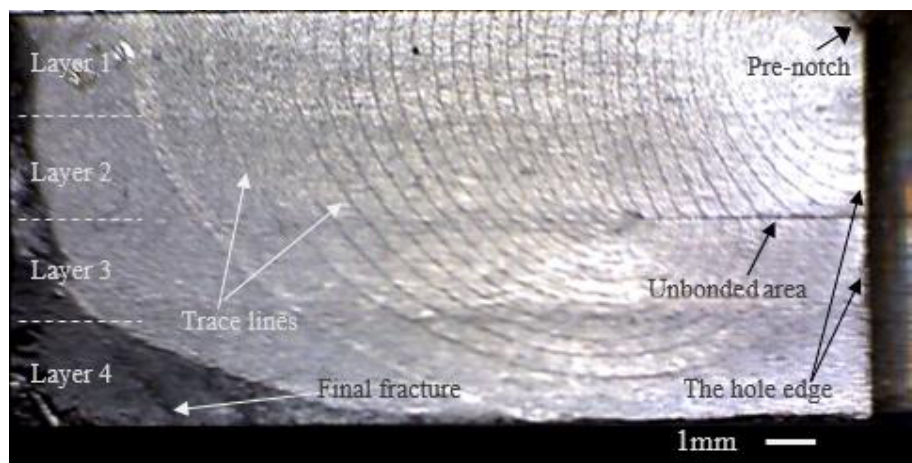
Figure 4. The base information of the fracture surface of Specimen A-1 in Group A. Table 3. The unbonded size reflected on the fracture surface and total cycles. Specimen